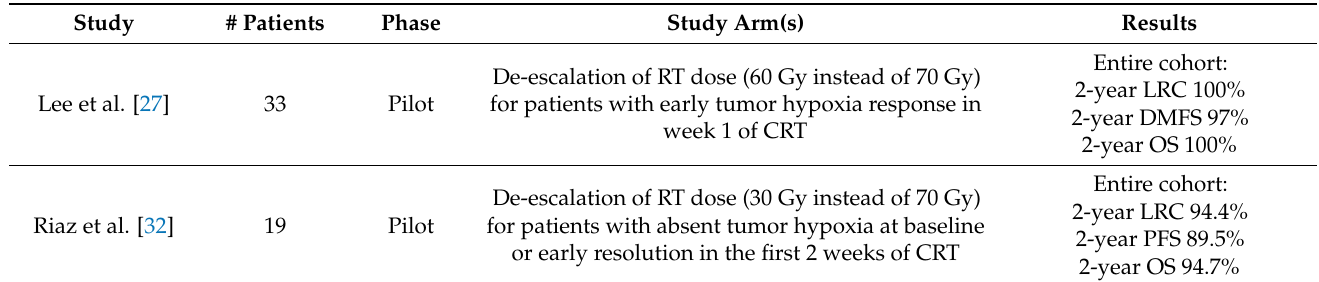
Table 3. Summary of de-escalation trials based on assessment of peritherapeutic tumor hypoxia dynamics. RT = radiotherapy, CRT = chemoradiation, OS = overall survival, PFS = progression-free survival, LRC = locoregional control, DMFS = distant metastasis-free